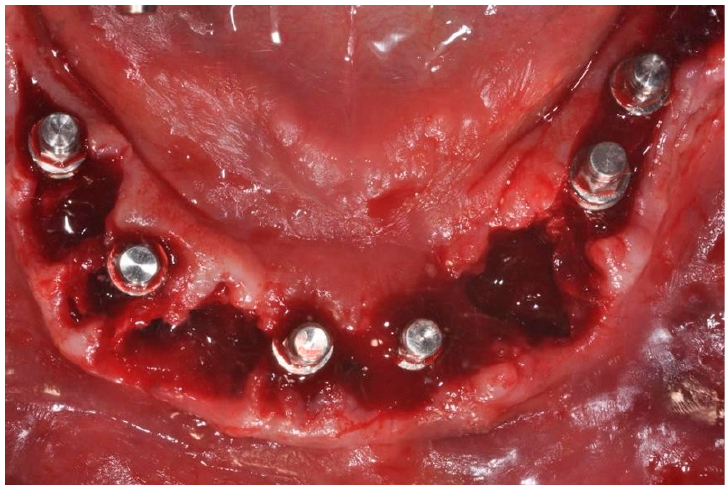
Figure 5. Surgical site after excision of compromised elements.